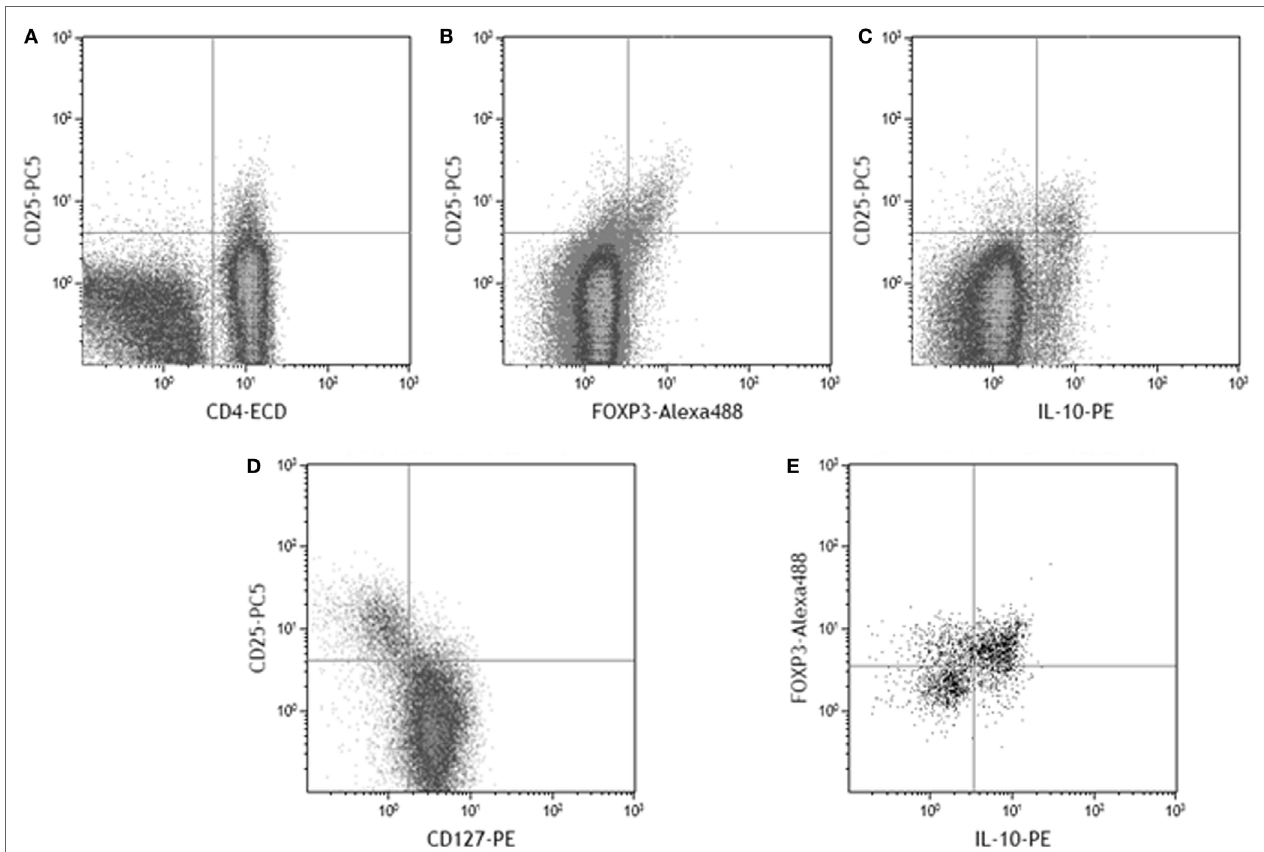
FigUre 2 | example flow cytometry dot plots to display the gating and designation of cD25 hi cells among PBMc lymphocytes . CD25 hi events were gated on the basis that expression is of higher intensity in CD4 + events (a) . Among gated CD4 + events, the CD25 hi population contains FOXP3 + events (B) , IL-10 + events (c) , and corresponds to the CD127 lo population (D) . Among gated CD4 + CD25 hi events, the majority of IL-10 + events were also FOXP3 + (e)